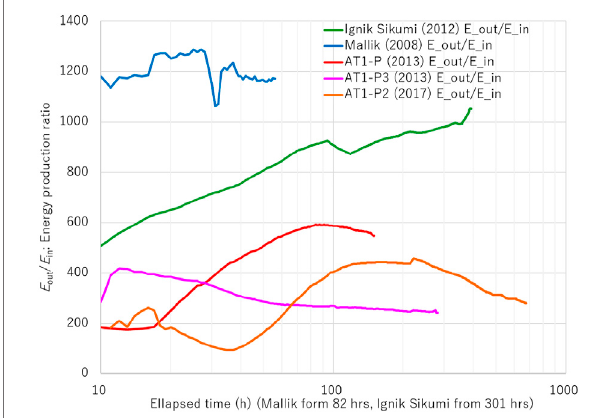
FIGURE 5 | Energy return (combustion heat from the produced gas, E out ) on investment as a work of the pump to displace water ( E in ) of the offshore production test wells (AT1-P, P2, and P3) in the eastern Nankai Trough (after Yamamoto et al.,